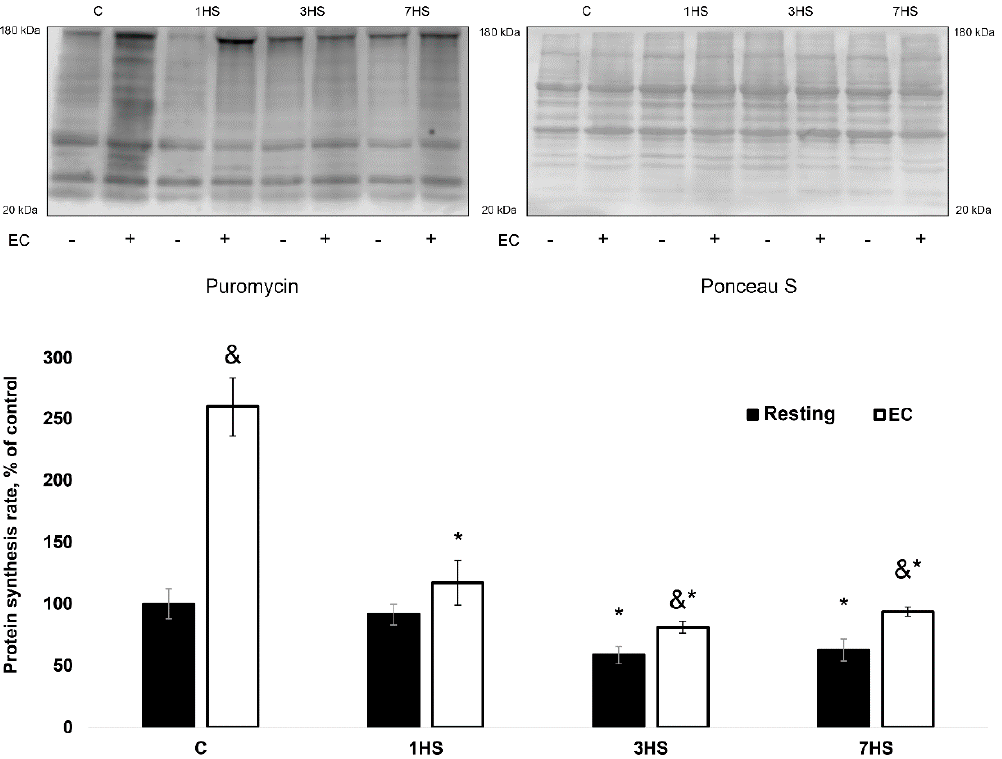
Figure 1. The rate of protein synthesis in the eccentrically-contracted rat soleus muscles following hindlimb unloading (experiment 1). Values are means ± SEM, expressed relative (%) to the control resting muscle; n = 7/group. C—control rats, 1HS, 3HS and 7HS—hindlimb unloading for 1, 3 and 7 days. The data were analyzed using 2-way ANOVA with post hoc Tukey. The main effect of HS p = 2.00459E-11, the main effect of EC p = 2.74866E-08, interaction effect p = 1.08513E-06; *—significant difference vs. C group ( p < 0.05), &—significant difference from the resting muscle of the same group ( p < 0.05). Black bars—resting muscle, white bars—eccentrically-contracted muscle.